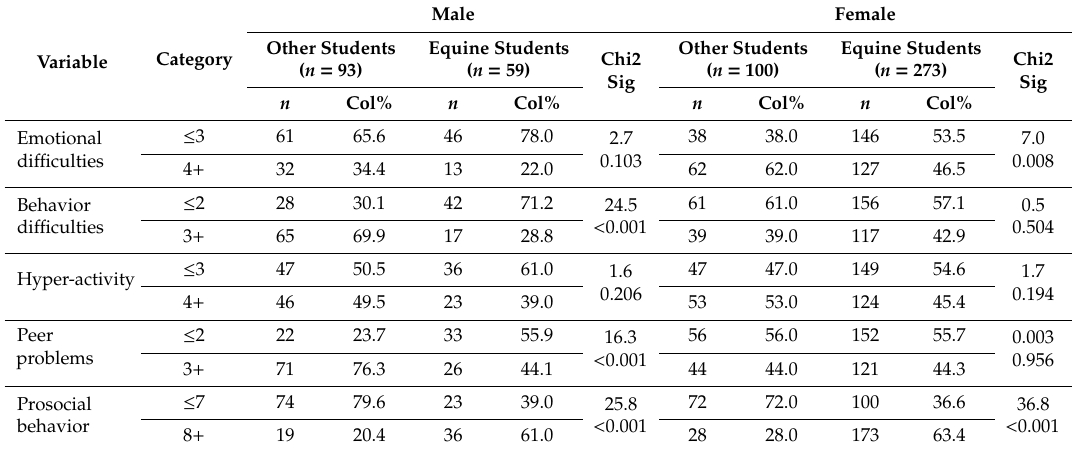
Table 2. Response variables by gender in groups equine students and other